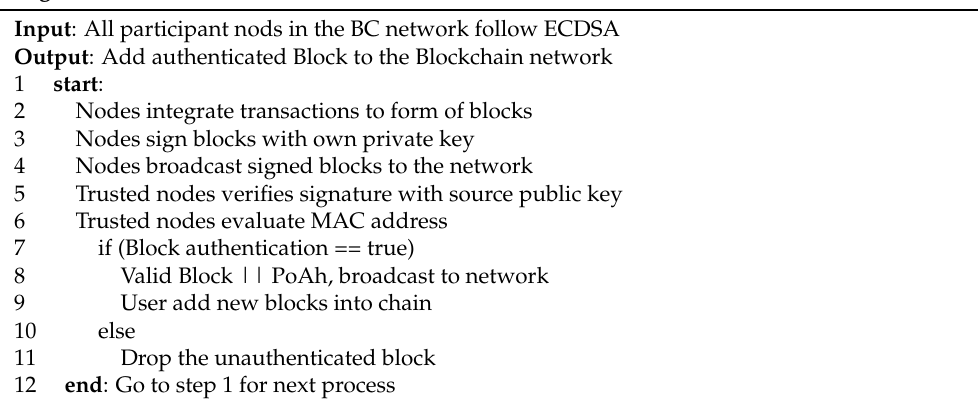
Algorithm 1. PoAh Execution